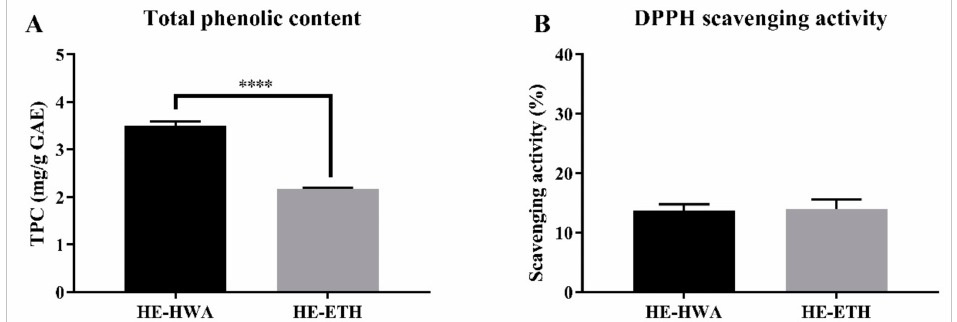
Figure 1. ( A ) Total phenolic content (TPC) and ( B ) 2,2-diphenyl-1-picrylhydrazyl (DPPH) radical scavenging activity of hot water (HE-HWA) and ethanolic (HE-ETH) extracts. Gallic acid equivalent (GAE)wasusedforrelativequantificationoftheTPCs. InDPPHscavengingassay, thefinalconcentration of HE-HWA and HE-ETH was 1 mg / mL. All values presented correspond to mean ± SD of three independent experiments ( n = 3). Values of **** p < 0.0001 was considered as statistically significant.